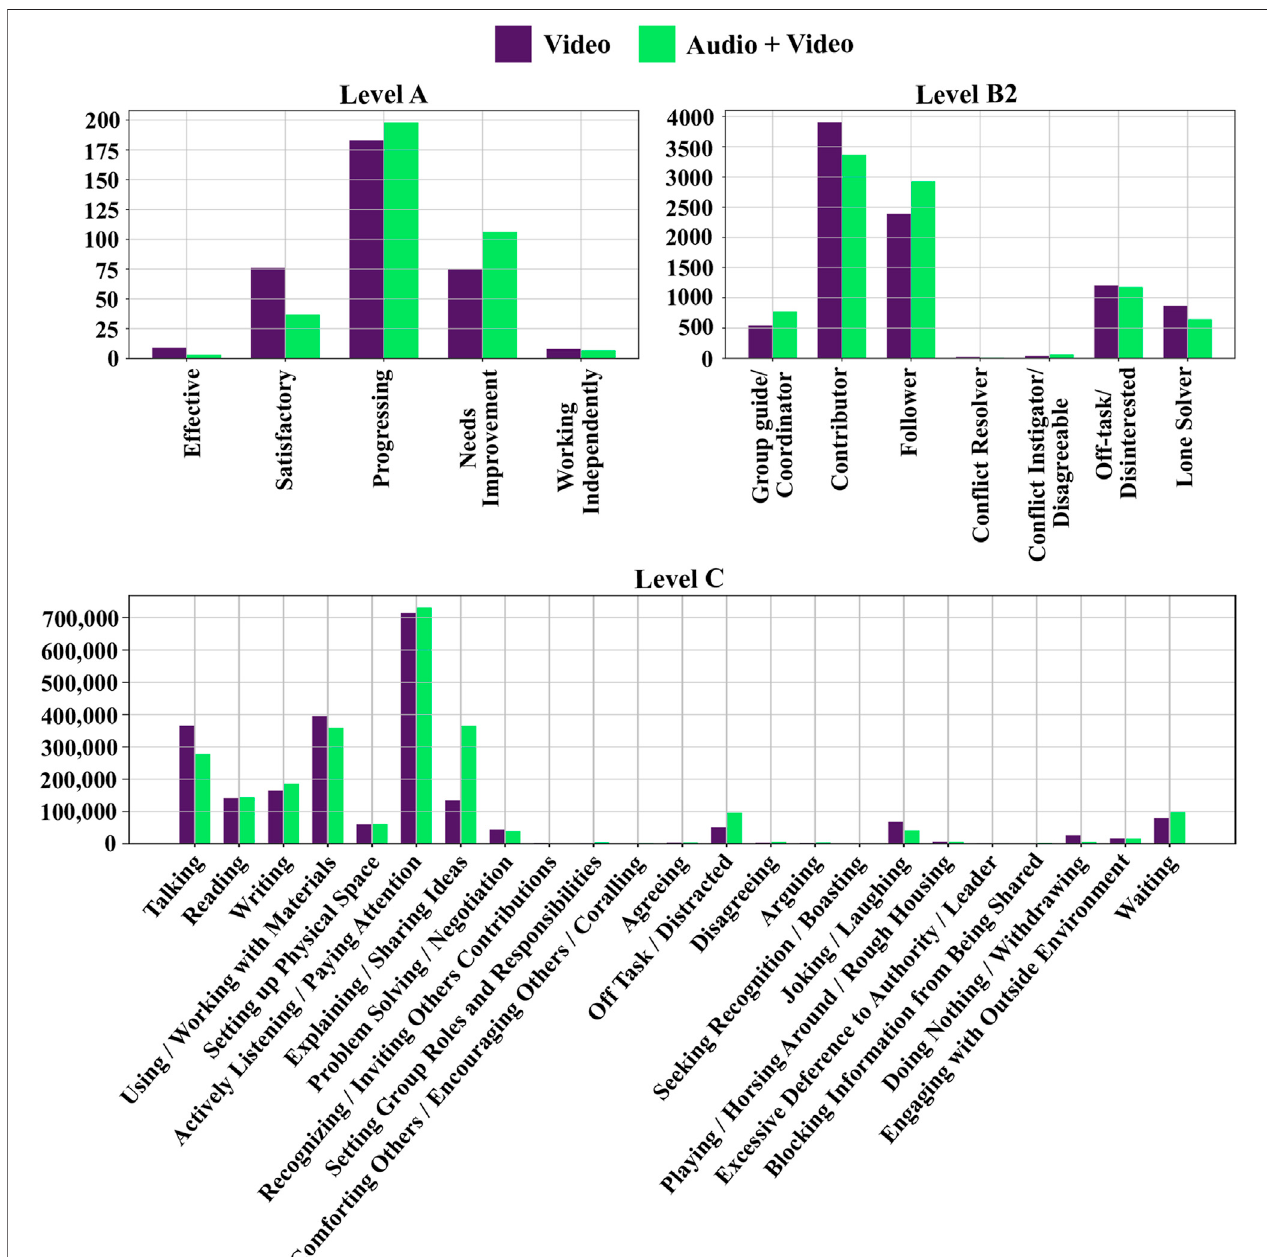
FIGURE2| DistributionofcodesforlevelsA,B2andC.Note,LevelAwascodedovereachtask.LevelB2codeswerecreatedover1minutetimesegments.Level C codes were coded using fl uid length segments and the distribution shown here was created by sampling at every 0.1 seconds. The distribution of Level A codes was fi rst illustrated in (Som et al., 2020).